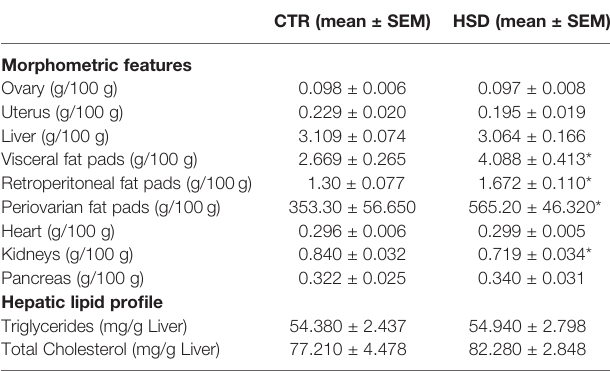
TABLE 1 | Morphometric and hepatic lipid pro fi le of CTR and HSD rats.